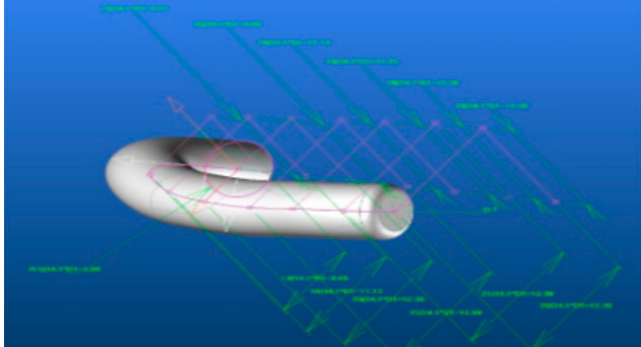
Figure 13. The coracoid process.